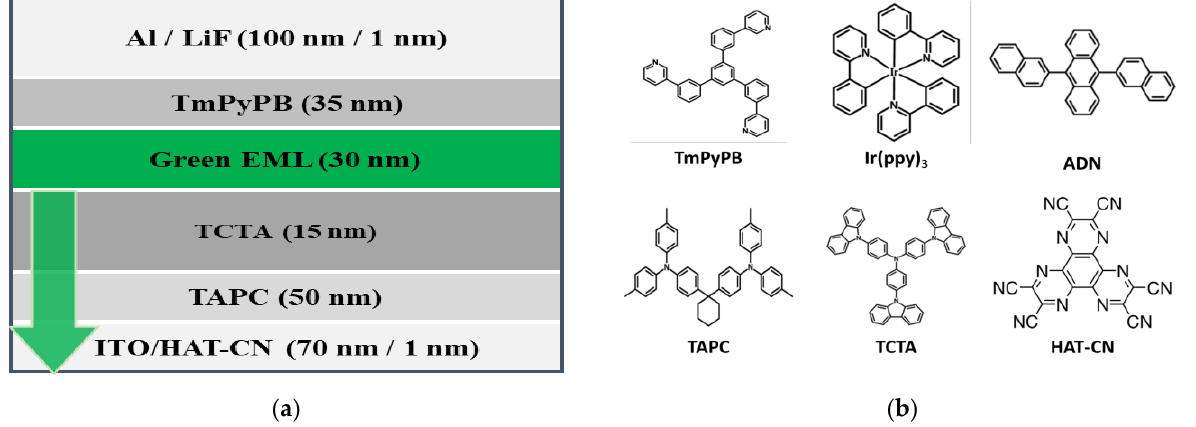
Figure 10. (a) OLED The OLED cell structure used , (b) Chemical structures of materials applied to Figure 10. ( a ) OLED The OLED cell structure used, ( b ) Chemical structures of materials applied OLED . to